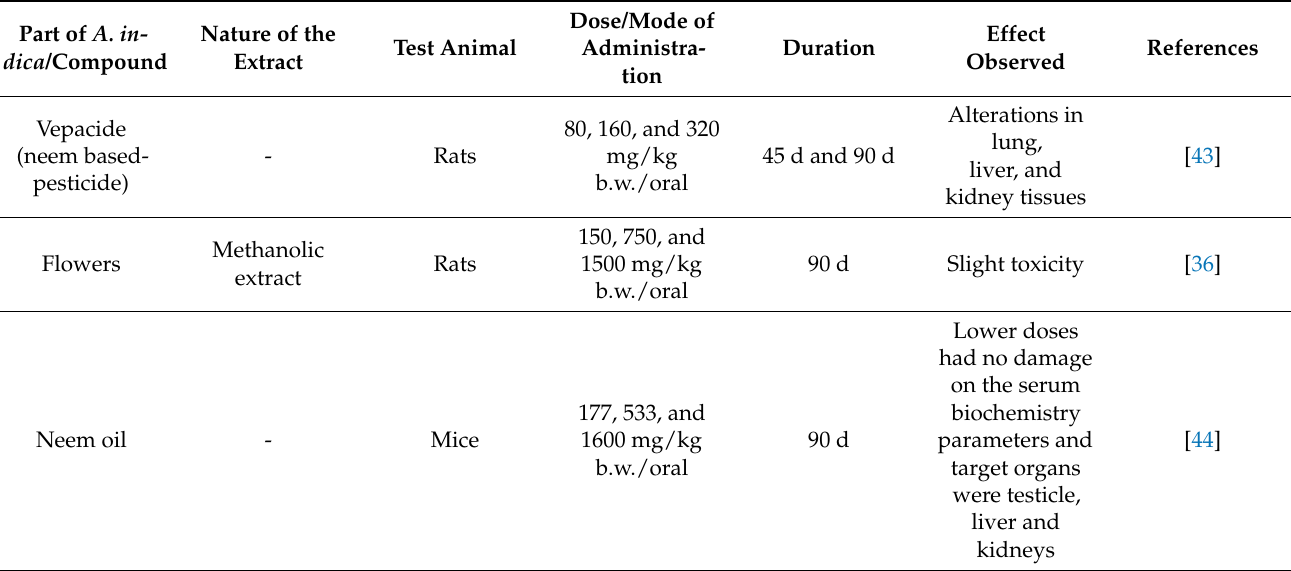
Table 4. Subchronic toxicity of neem in different